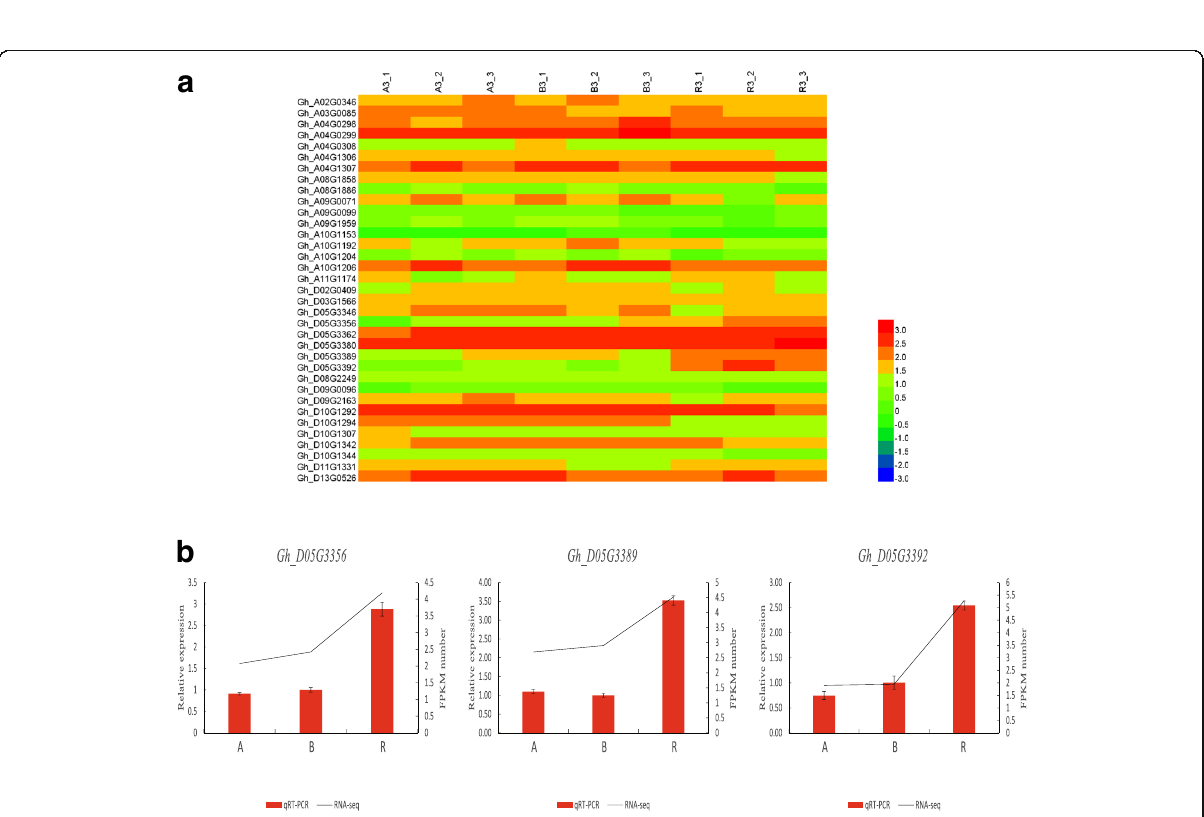
Fig. 2 qRT-PCR analysis of RFL gene expression compared with the RNA-seq data from three-line hybrid cotton lines (CMS-D2 line A, maintainer line B, and restoration line R). a The RNA-seq data of RFL genes in A, B and R lines. b The qRT-PCR analysis of three differentially expressed RFL genes. The red columns represented the relative expression levels of the genes; the black lines represented the FPKM number. A: CMS-D2 line, B: maintainer line, R: restorer